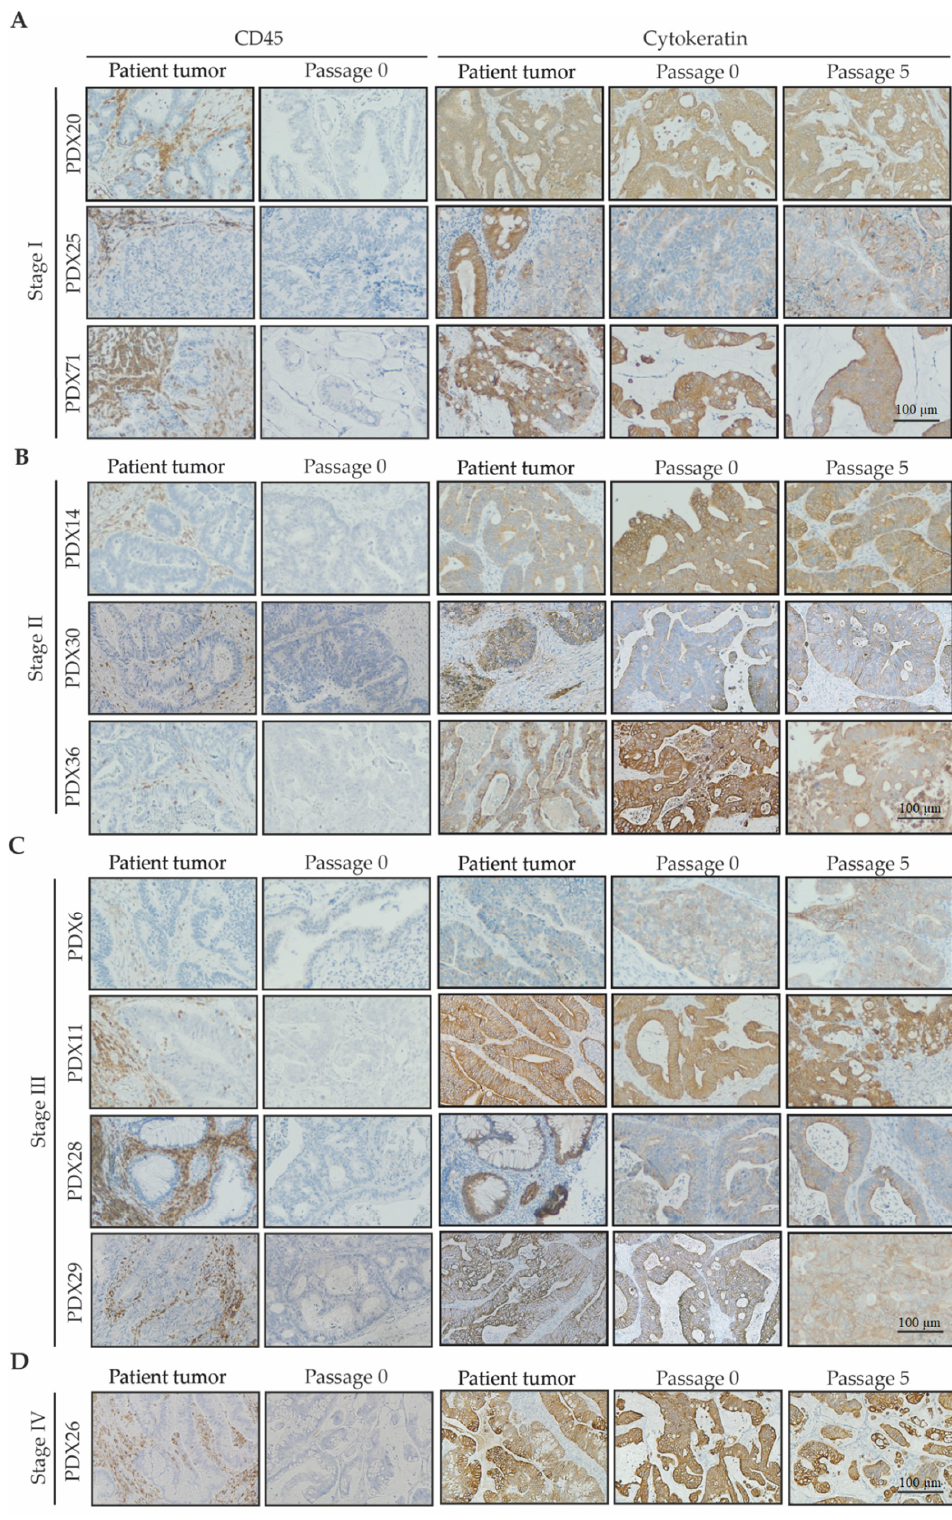
Figure 4. Immunohistochemical characterization of leukocytic infiltrates in CRC patient-derived xenografts. Representative human CD45 and pan-cytokeratin immunohistochemistry images of the patient tumor and indicated passages from the PDX lines from ( A ) stage I; ( B ) stage II; ( C ) stage III; and ( D ) stage IV tumors; scale bar for A-D is 100 µm and applies to all images.